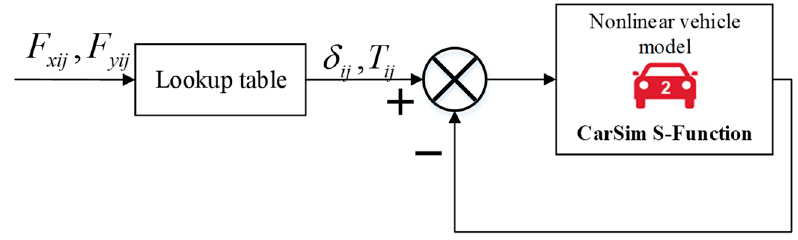
F igure 10. Structure of actuator control layer. Figure 10. Structure of actuator control